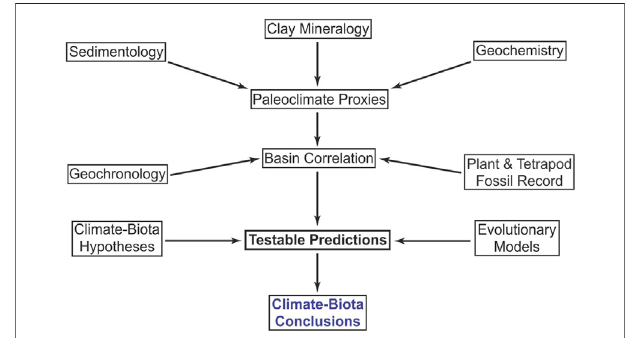
FIGURE2| Conceptual fl ow diagram explaining how we synthesized data to test hypotheses for biotic response to climate change in Triassic sediments of the Ischigualasto-Villa Unión Basin, Argentina. Multiple types of geologic data ( Sections 3 – 3.1 ) were used to infer paleoclimaticproxies( Sections 4.1 – 4.4 ), which werecombinedwithdata from the fossil record ( Sections 3.2 , 4.5 – 4.6 ) and geochronologic age constraints through basin correlation. These integrated data were then used to test predictions ( Sections 1.3 , 3.3 , 4.7 ) derived from applying explicit evolutionary models ( Section 1.2 ) to previously-proposed hypotheses ( Section 1.1